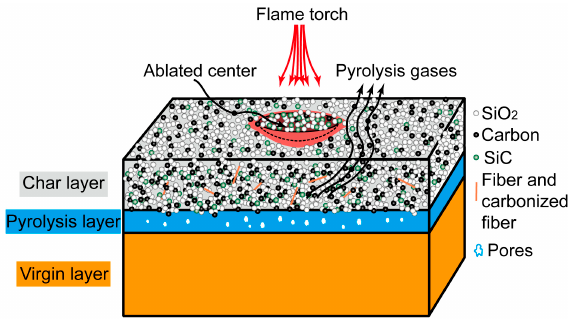
Figure 11. A schematic representation of the ablation process of basic SR composite.